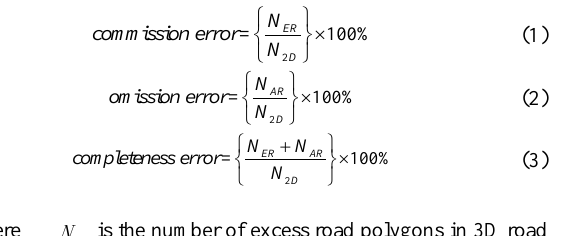
Figure 1. Workflow for the 3D road polygon creation The workflow includes three main steps: elevation information extraction, road elevation interpolation, and quality assessment. Stage 1: Road area points are extracted from the point cloud. Accurate vector GIS road edges are used as geometric constraints for the point extraction. The point on the road kerb sides is excluded to eliminate the noise of road surfaces. The point cloud within the road boundary is extracted for use in later